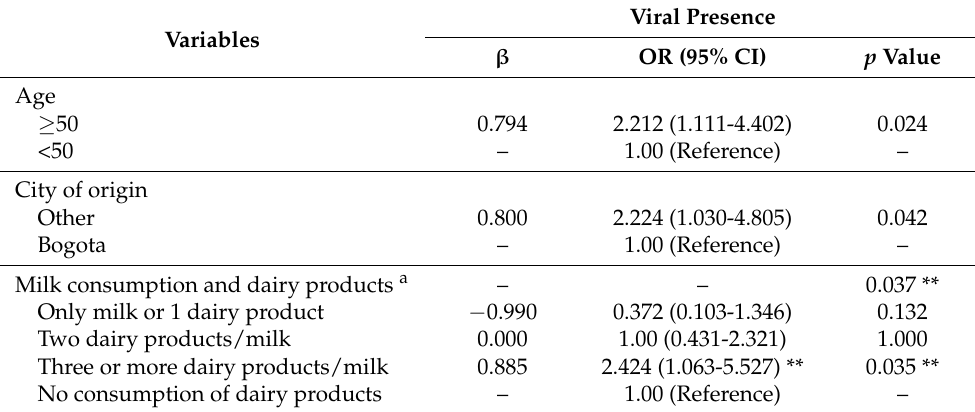
Table 2. Multinomial logistic regression of the risks of exposure and viral presence in the human population. Odd-ratio values adjusted by